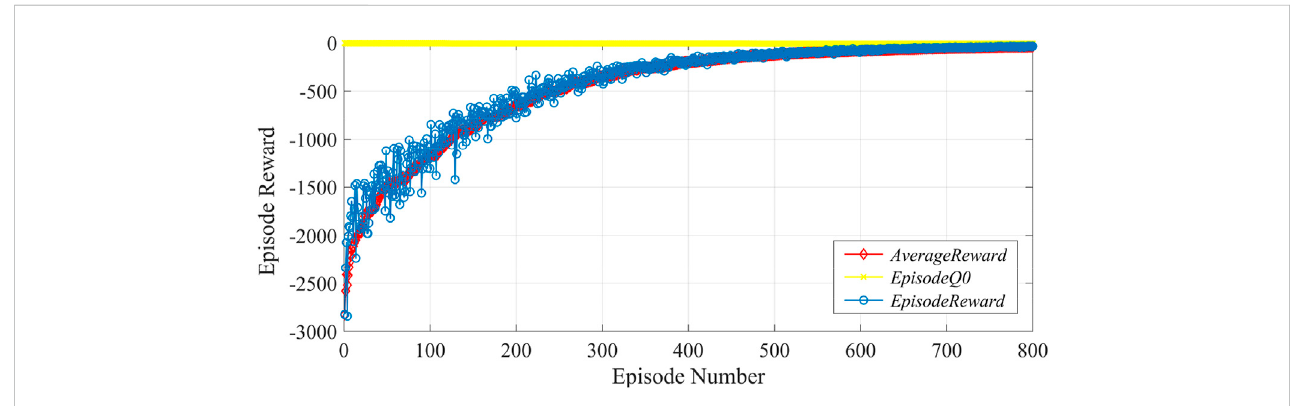
FIGURE 12 DDPG agent training